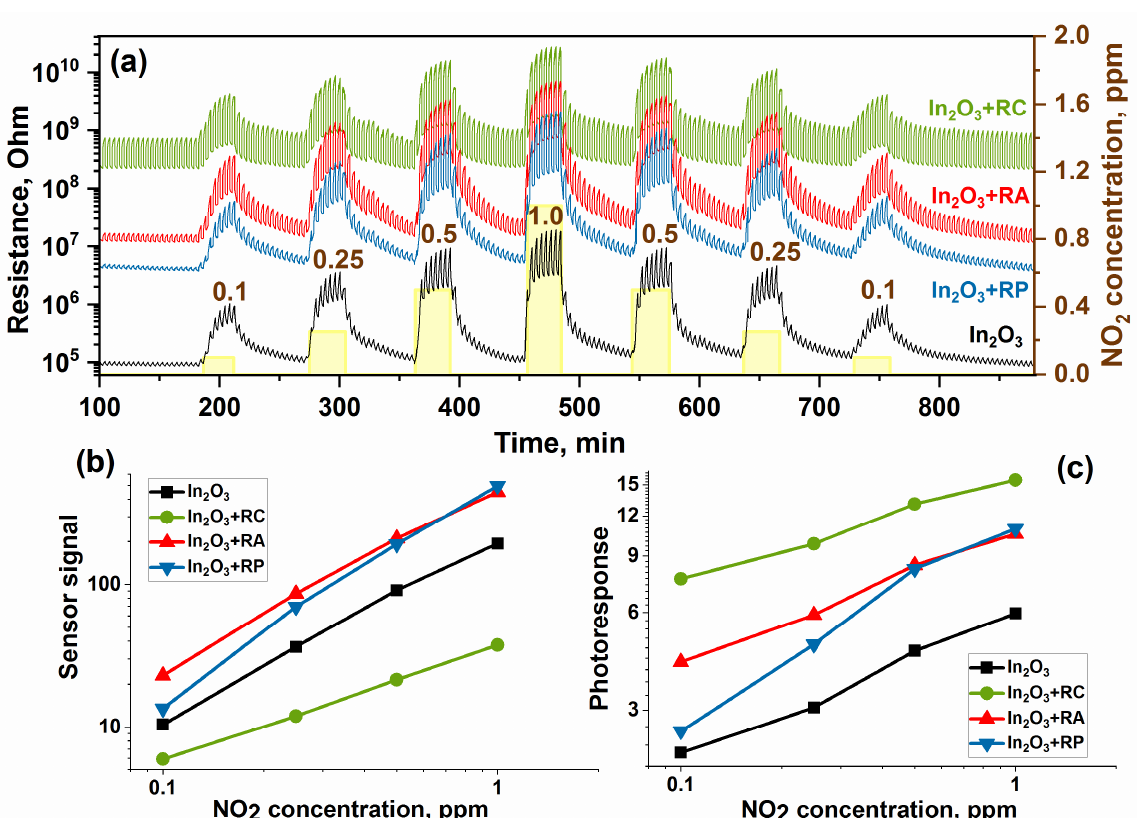
Figure 4. Change in resistance ( a ), correlation of the sensor signal ( b ), and photoresponse ( c ) versus NO 2 concentration of the samples. NO 2 concentration of the